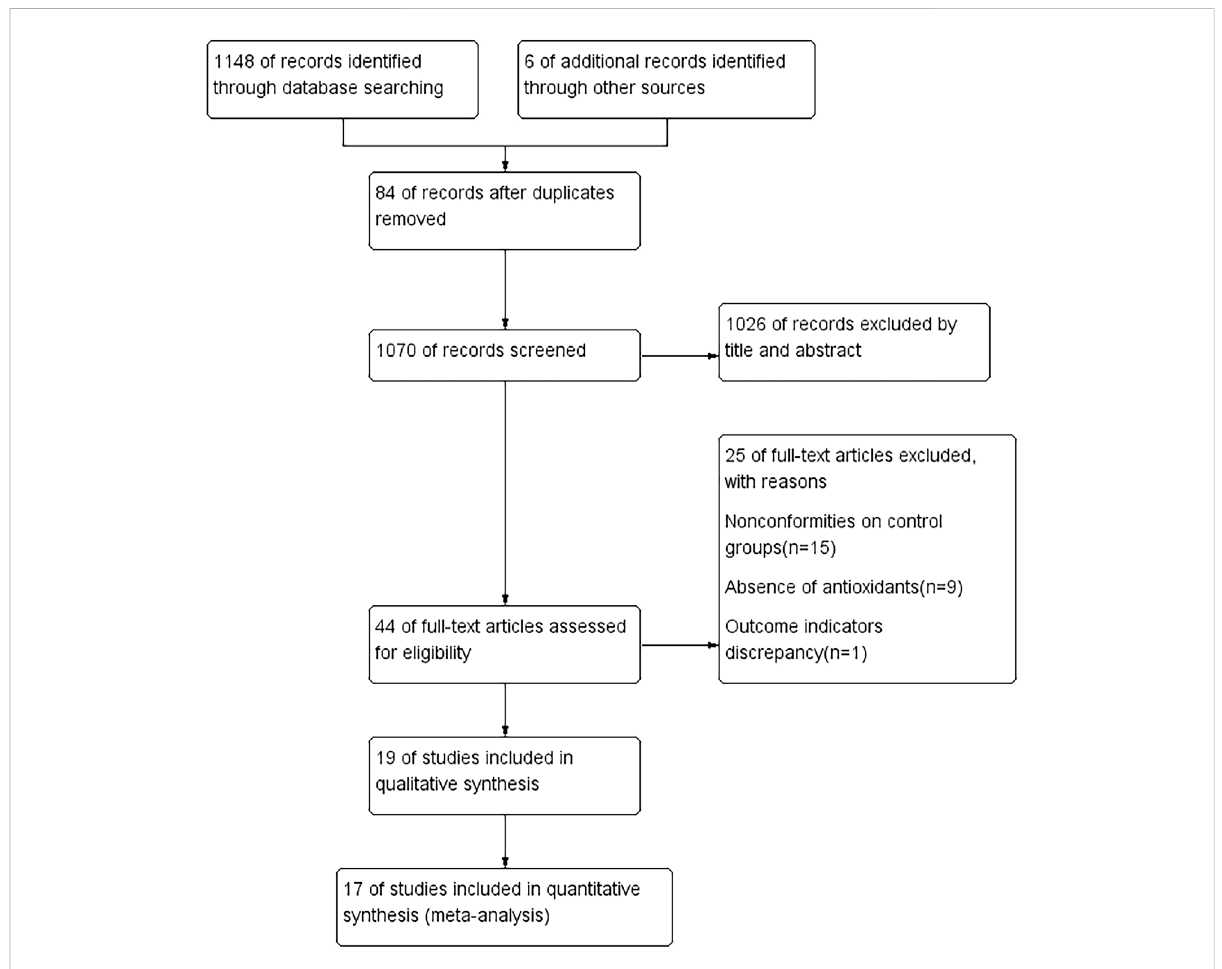
FIGURE 1 Flow diagram of literature search according to the PRISMA